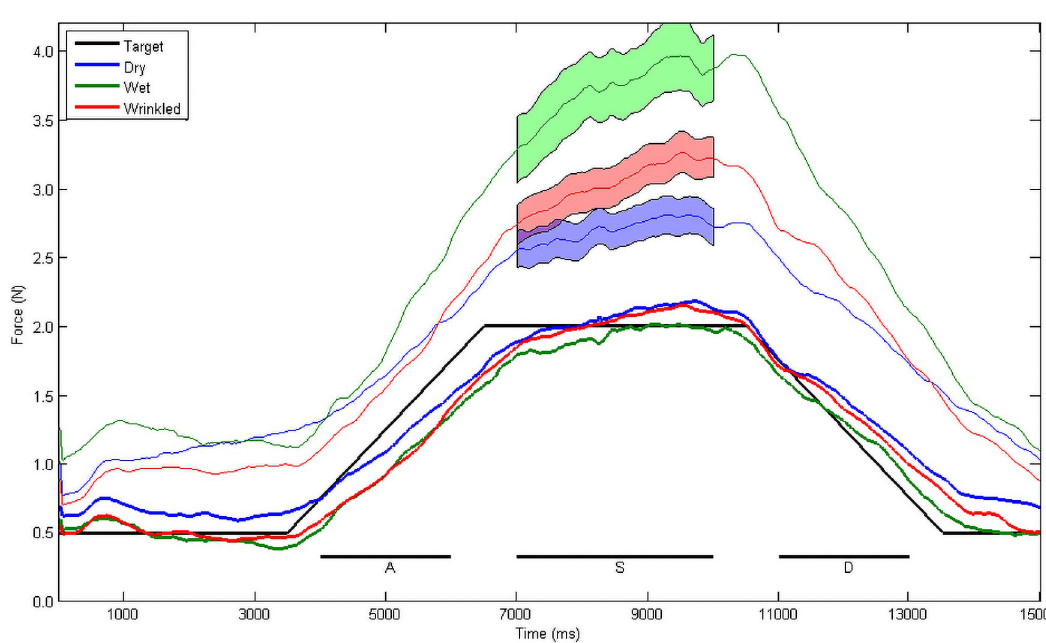
Fig 2. Comparison of performance across conditions. Mean grip force (thinner traces) and load force (thicker traces) when participants tracked a load weight target (black line). Participants with wrinkled fingers produced a grip force that did not differ from that used by people with dry fingers in the static hold phase, however people with wet but non-wrinkly fingers used a significantly higher amount of grip. The shaded area indicates the pointwise ± 1 standard error of each mean trace. Lines below the trace indicate the attack phase (A) of the trial, the static phase (S) and the decay phase